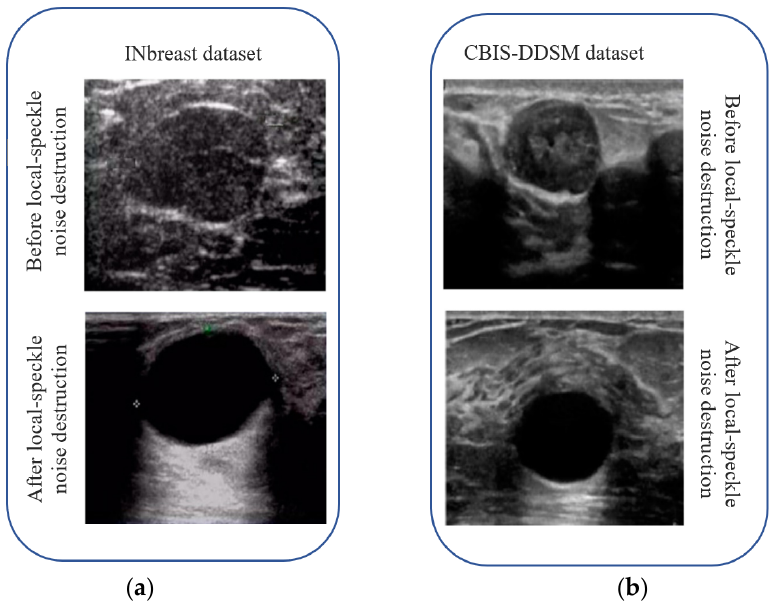
Figure 8. INbreast and CBIS-DDSM dataset image comparison ( a ) before and after the destruction; ( b ) before and after the local speckle destruction.